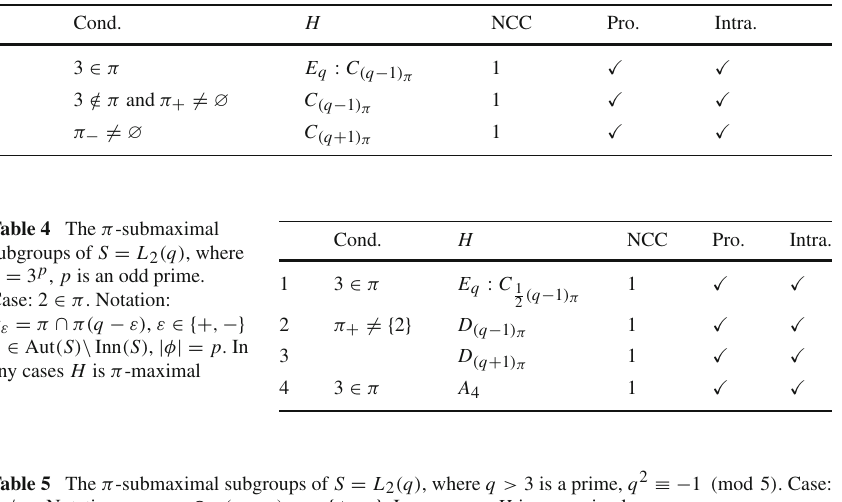
Table 3 The π -submaximal subgroups of S = L 2 ( q ) , where q = 3 p , p is an odd prime. Case: 2 / ∈ π . Notation: π ε = π ∩ π( q − ε) , ε ∈ {+ , −} . In any cases H is π -maximal Cond.